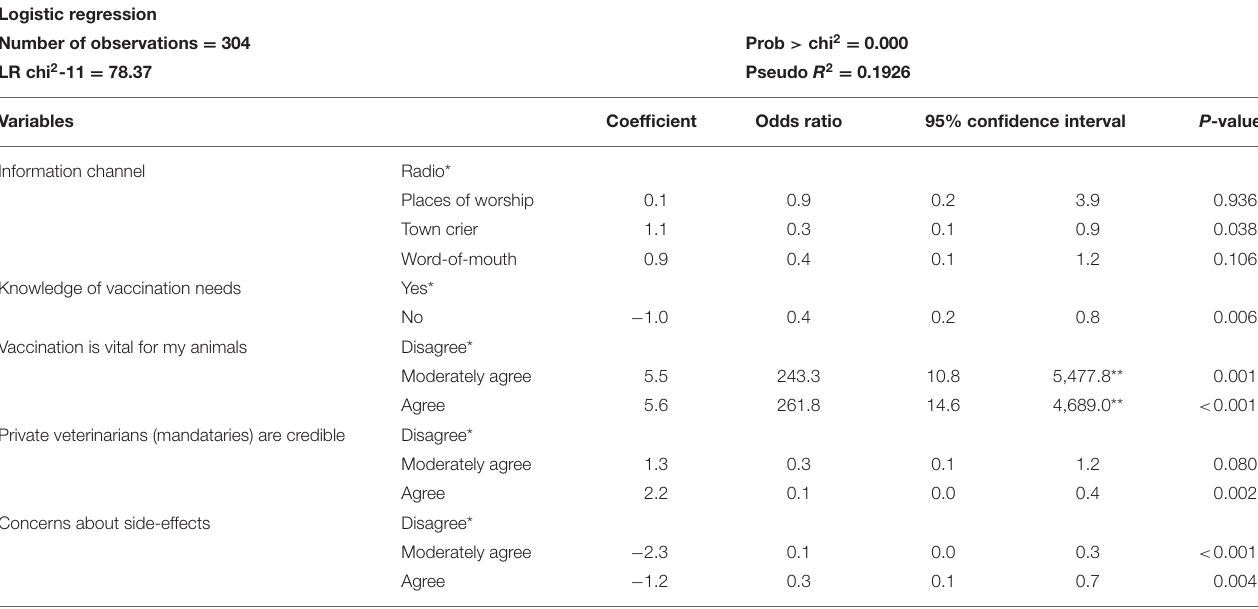
TABLE 4 | Factors influencing the WTV outside the vaccination campaigns. Logistic regression